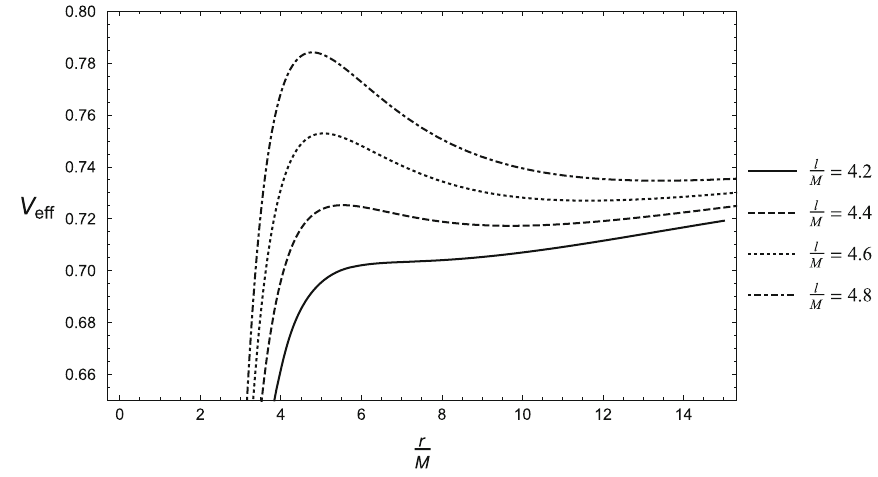
Fig. 2 V ef f with various value of (cid:21)/ M ( κ/ M 2 = 5 and (cid:19) = 0 .